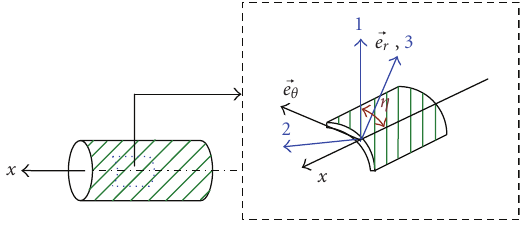
Figure 4: The definitions of the principal coordinate axes on an arbitrary layer of the